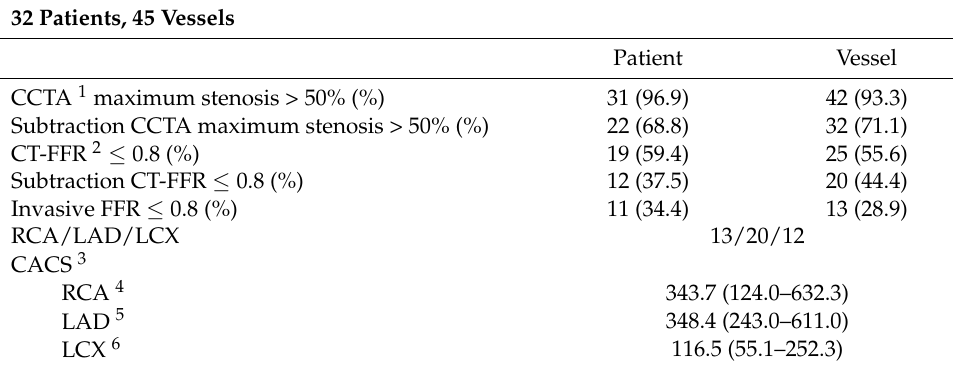
Table 2. Vessel characteristics.